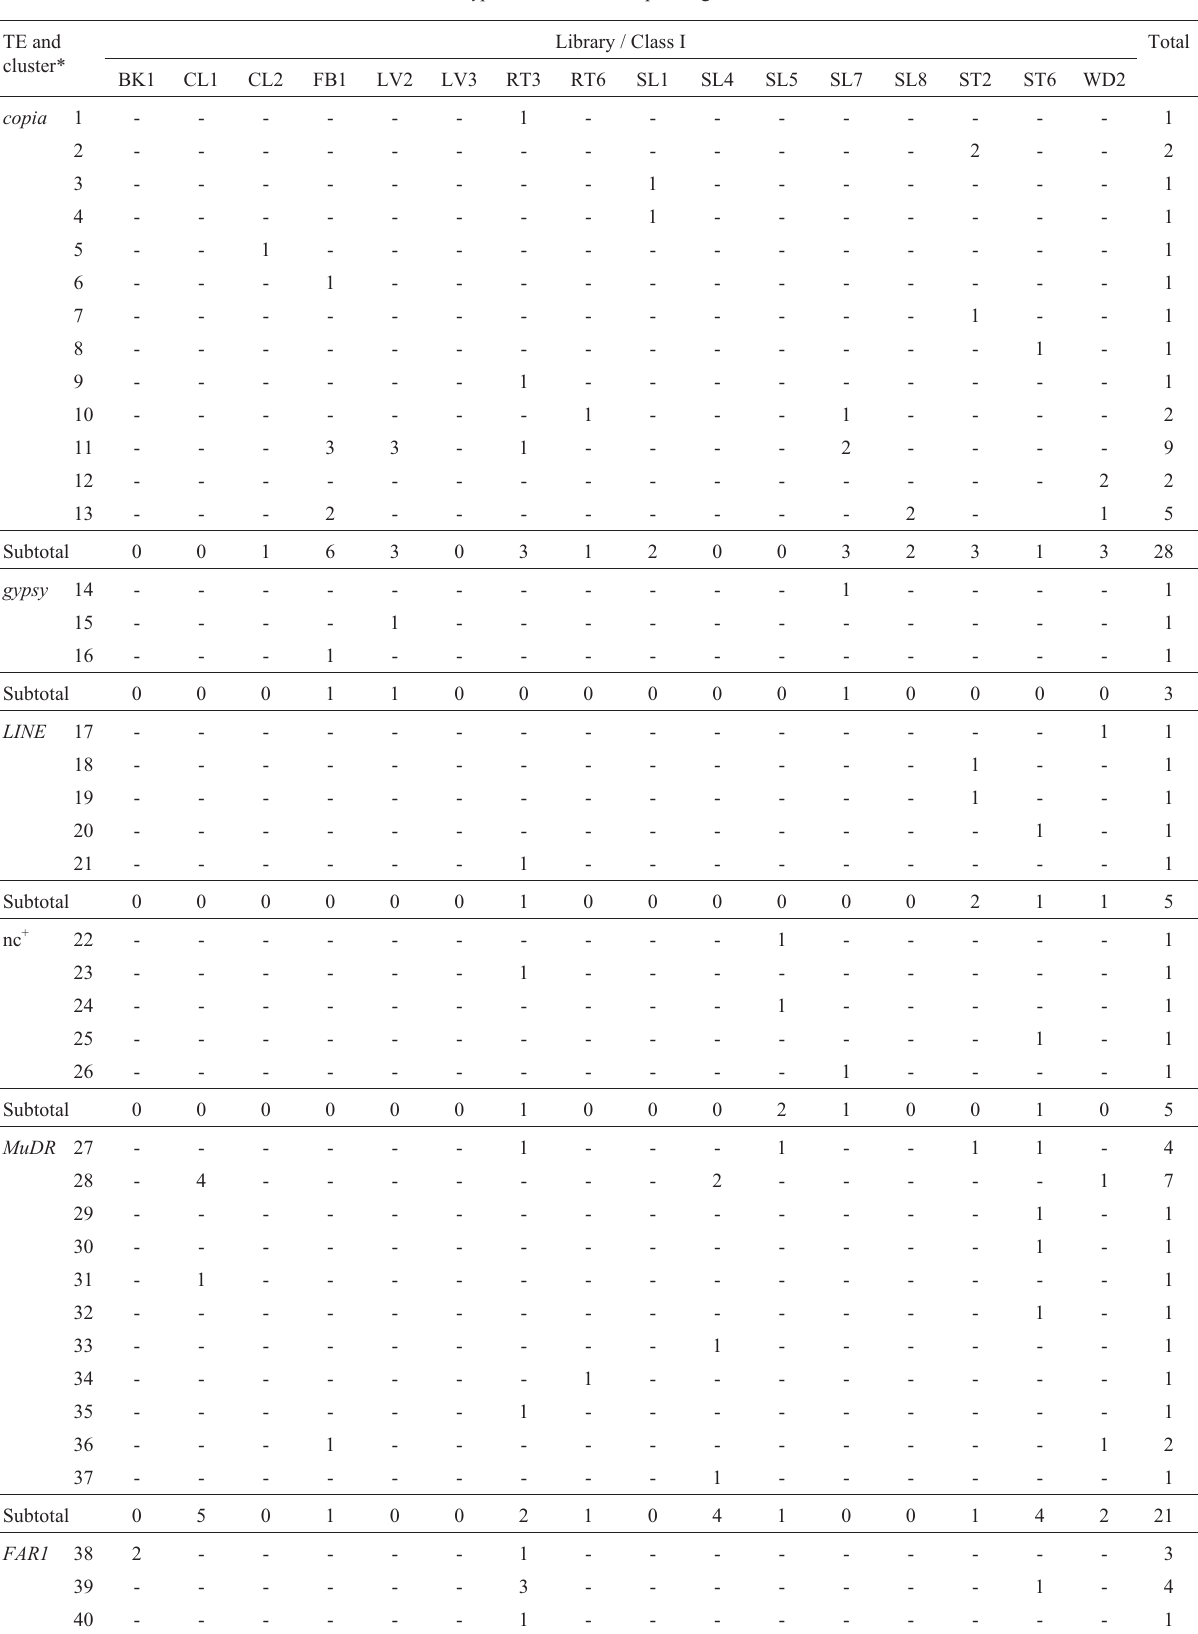
Table 2 - Number of TE EST in different libraries of Eucalyptus and their corresponding